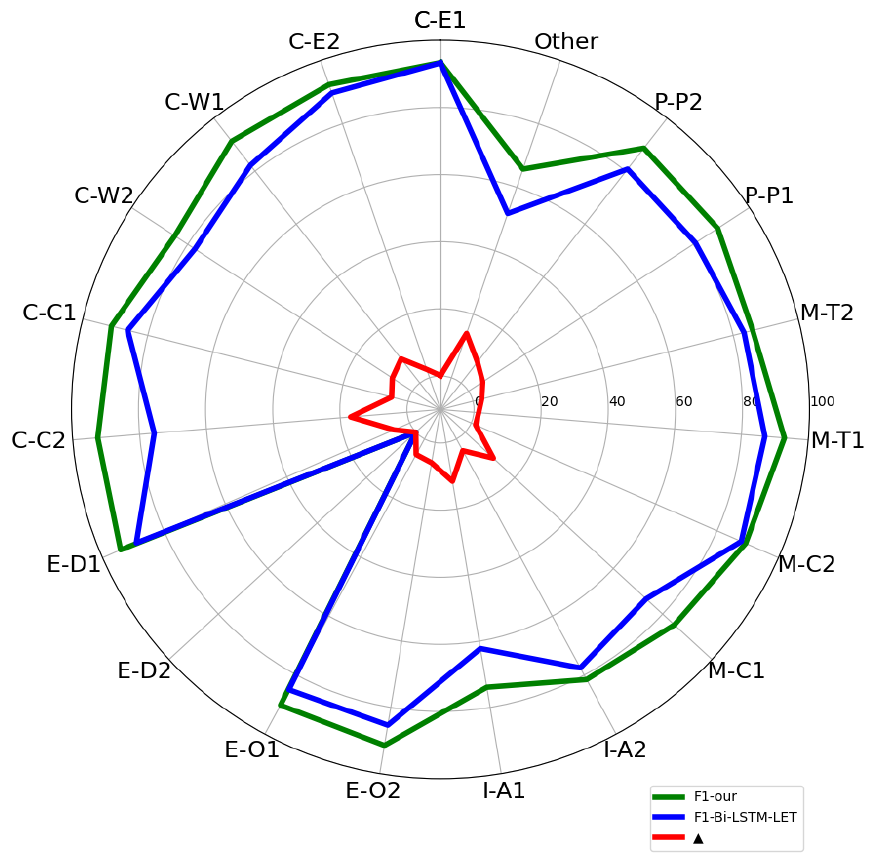
Figure 5. Visualization of the experimental effects of the two models on the SemEval-2010 Task8